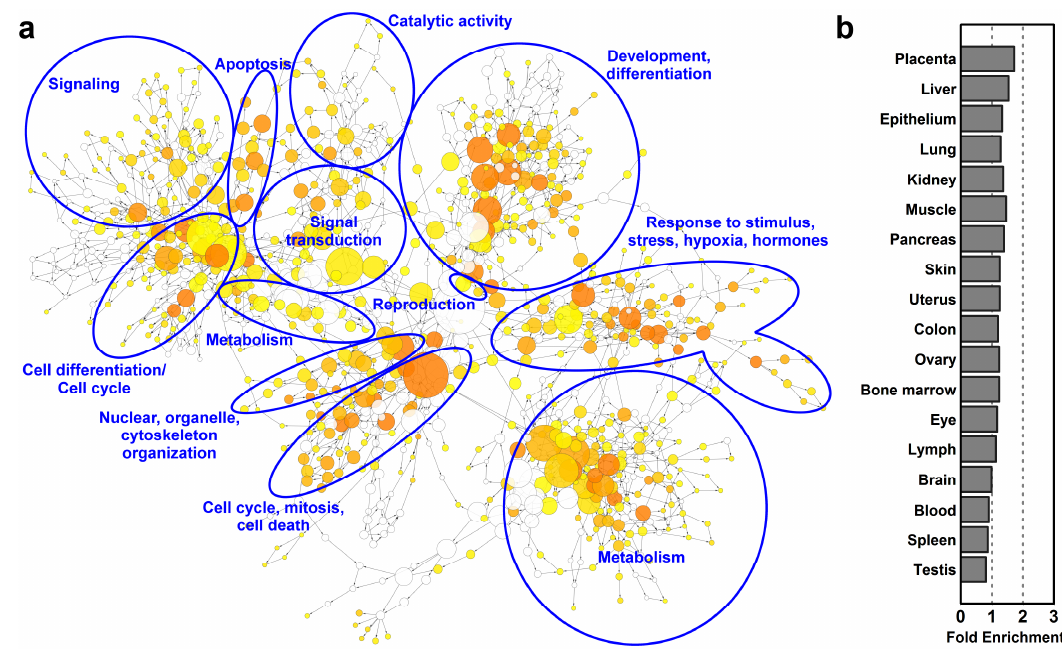
Figure 3. Gene-regulatory networks, biological processes and tissue enrichments in differentiating villous trophoblasts. ( a ) The network of biological processes enriched among differentially expressed (DE) genes was created by BiNGO and visualized with Cytoscape. Sizes of the circles relate to the number of genes involved in the biological processes and colors refer to p -values. The groups of most enriched biological processes were manually circled and labeled. The color code depicts p -values. ( b ) The UniProt tissue enrichments among DE genes were assessed with DAVID and are represented in a bar chart in the order of their enrichment significance value.